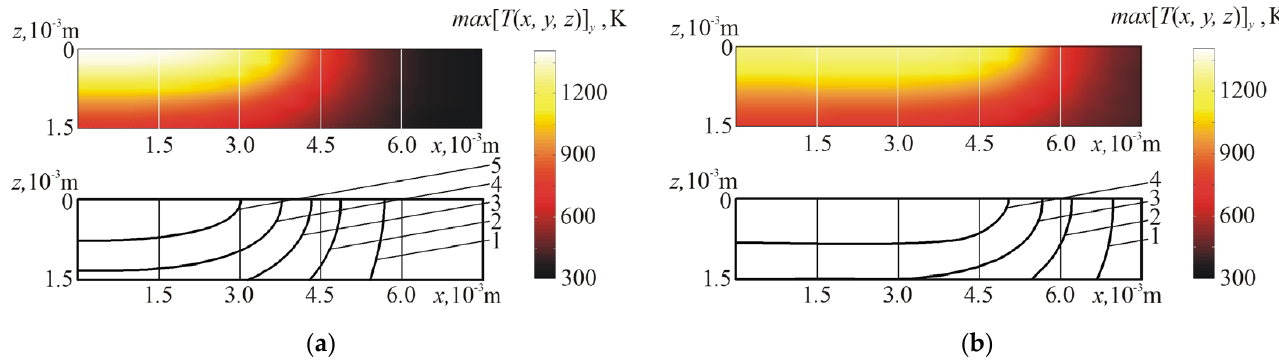
Figure 3. The calculation results of maximum temperature values max [ T ( x , y , z )] y across the width of the heat-affected zone of a rectangle-shaped heat source with power Q = 950 W moving at a constant linear velocity υ = 1.1 × 10 − 2 m/s on the surface of chrome–nickel–molybdenum steel before ( a ) and after adaption of the power density ( b ). Temperature T : (isothermal: 1—600 K; 2—750 K; 3—900 K; 4—1050 K; 5—1200 K) [65].